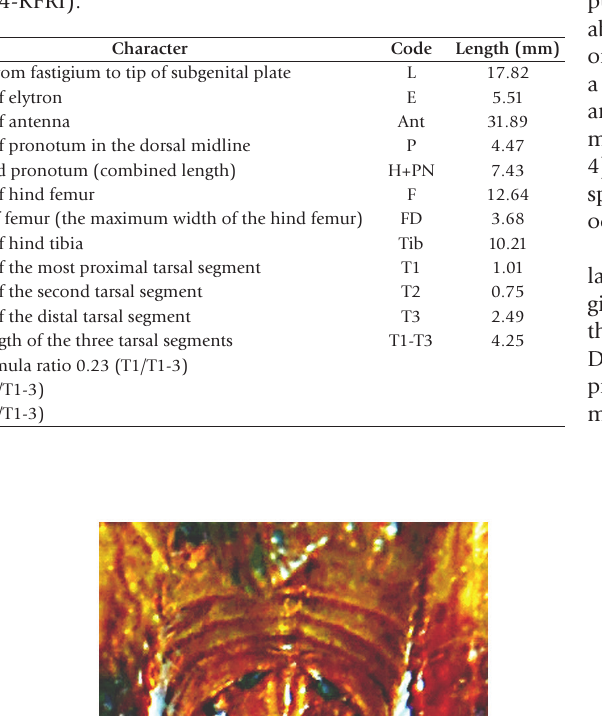
Table 2. Measurements of male Mopla guttata (specimen OR0024-KFRI).